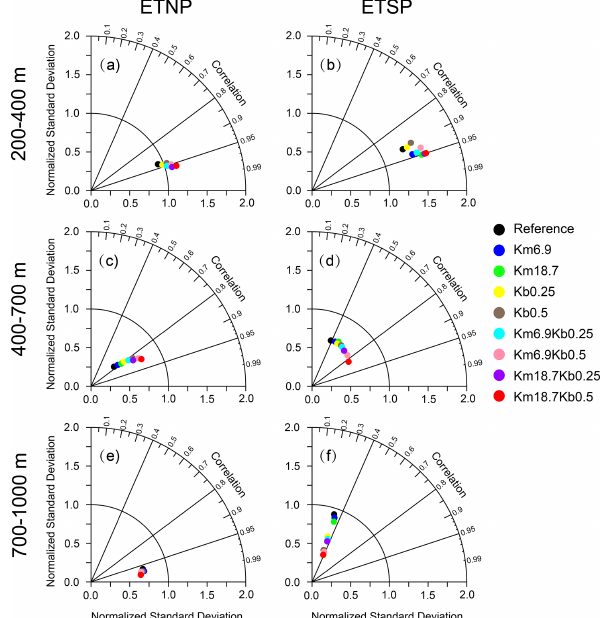
Figure 5. Taylor diagrams for the performance of simulated DO concentration (against WOA2013) from model simulations for ETNP (5–20 ◦ N, 165–90 ◦ W; a, c, e ) and ETSP (10–3 ◦ S, 110–